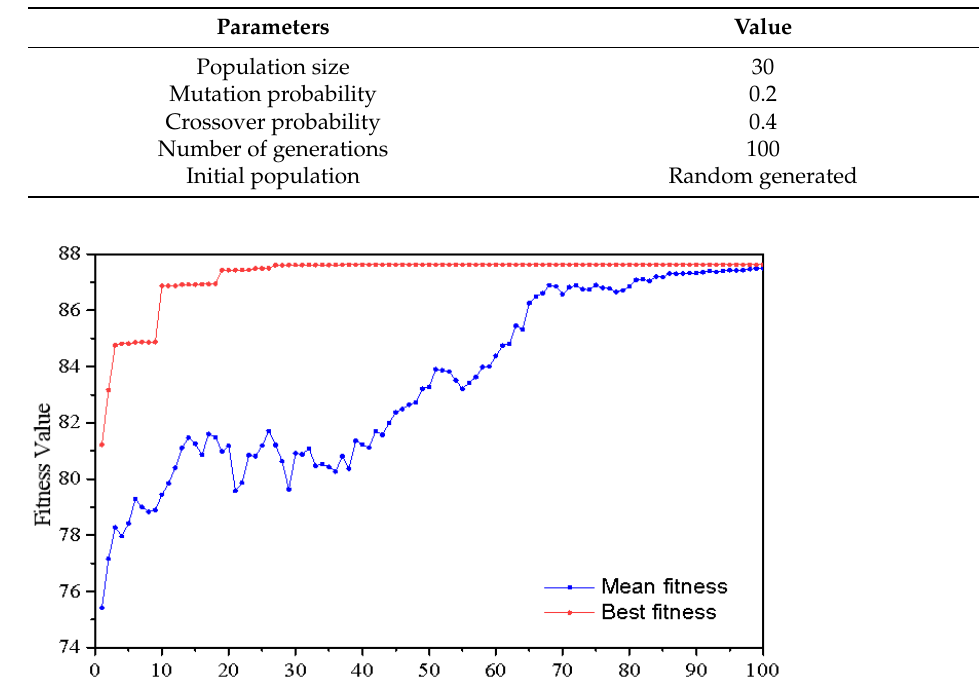
Figure 15. Best fit convergence of genetic algorithm (GA)–BPNN. After genetic algorithm optimization, the results obtained were as follows: the max- imum predicted output value was 87.62, and the independent variables a, b, c, d, and e had the values of 91.7, 537.8, 1157.2, 487.7, and 298.9, respectively. To verify the reliability of the optimization results, the optimization parameters of the selected model were tested. The grinding fineness, combined activator agent dosage, sodium sulfide dosage, isoamyl xanthate dosage, and inhibitor dosage were 92%, 550 g/t, 1150 g/t, 500 g/t, and 300 g/t, respectively. A recovery of 87.35% was achieved, which corresponds to the grade of 2.68%. Moreover, the flotation recovery was nearly 2% higher than that before the optimization. The results showed that the model based on the genetic algorithm and BP neural network,